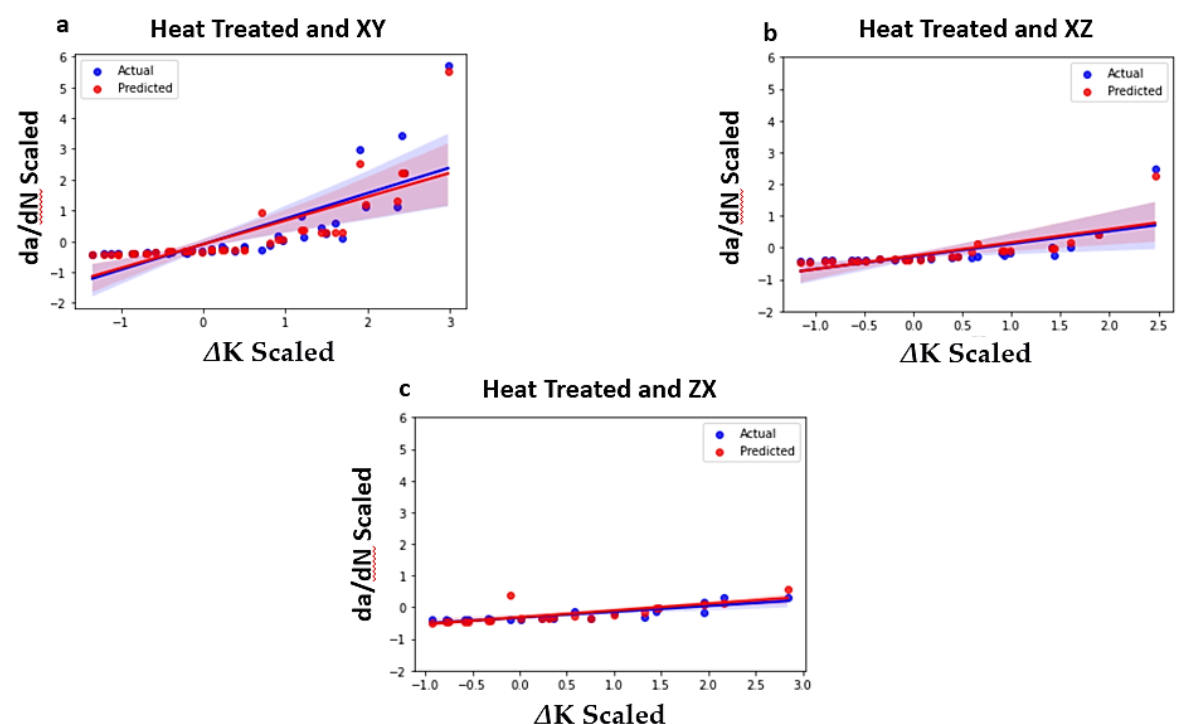
Figure 4. Actual and Prediction Plots for Heat treated Samples of Ti-64 alloy. ( a ) XY Specimen Orientation; ( b ) XZ Specimen Orientation and ( c ) ZX Specimen Orientation.